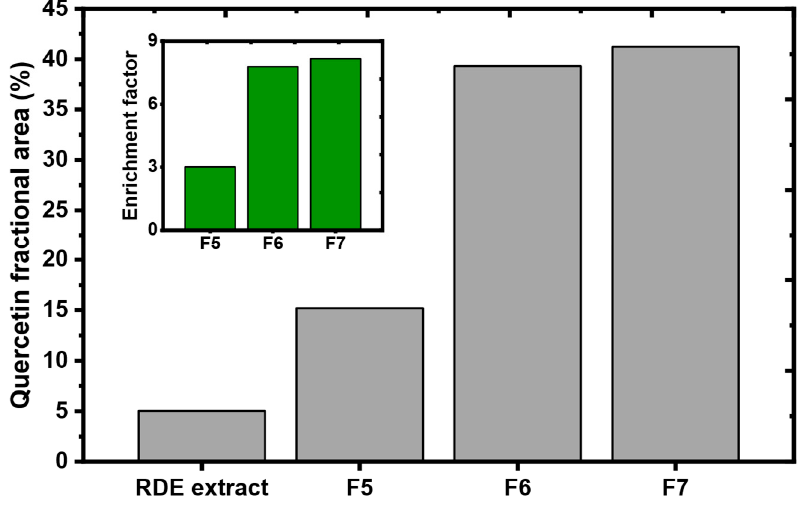
Figure 10. Fractional area of quercetin in RDE extract and consequent fractions (5, 6 and 7). Inset: Enrichment factors of quercetin in the last three fractions.